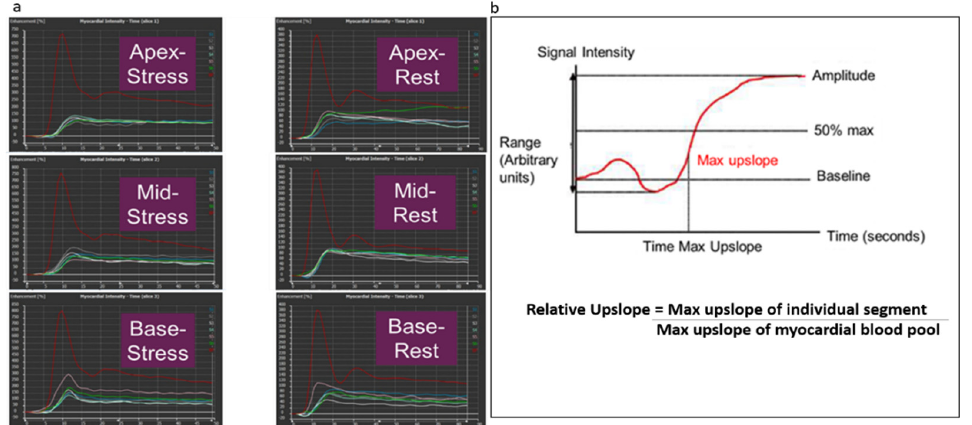
Figure 3. Semi-quantitative myocardial perfusion analysis. ( a ) shows time–signal intensity (TSI) curves for basal, mid ventricular and apical slices during rest and stress states. The TSI curve in red represents the myocardial blood pool. The other curves of various colors represent the myocardial segments at the basal, mid ventricular and apical levels. ( b ) demonstrates all the variables obtained from each time–signal intensity curve for each segment at stress and rest state, and calculation of the relative upslope as maximum upslope of individual segment/maximum upslope of myocardial blood pool.